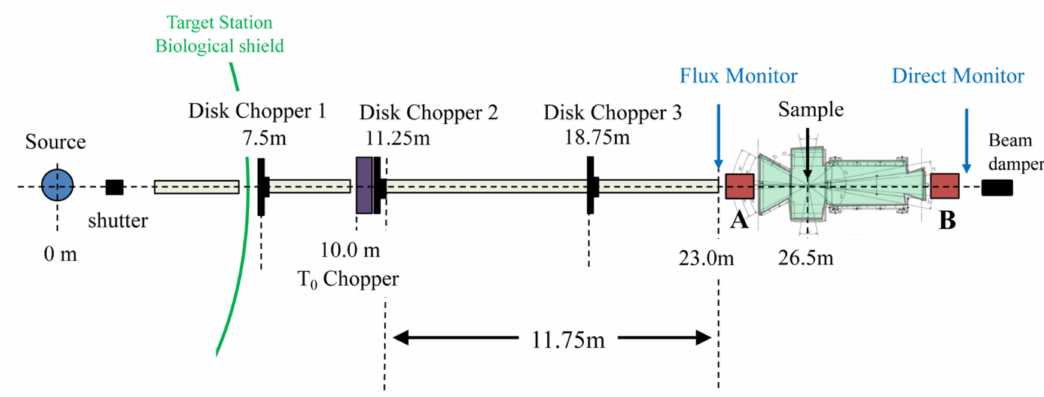
Figure 2. Schematic diagram of BL20 beam line. Upstream of the iMATERIA spectrometer, as indicated by A, new collimation, a polarizing mirror and p-flipper have been installed. Downstream at B, a USANS detector is under development.